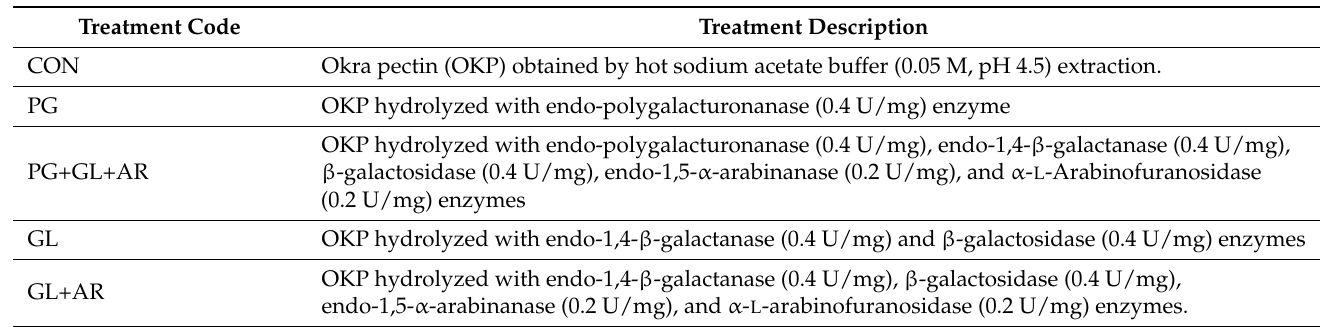
Table 1. Enzyme treatment description. Treatment Code Treatment